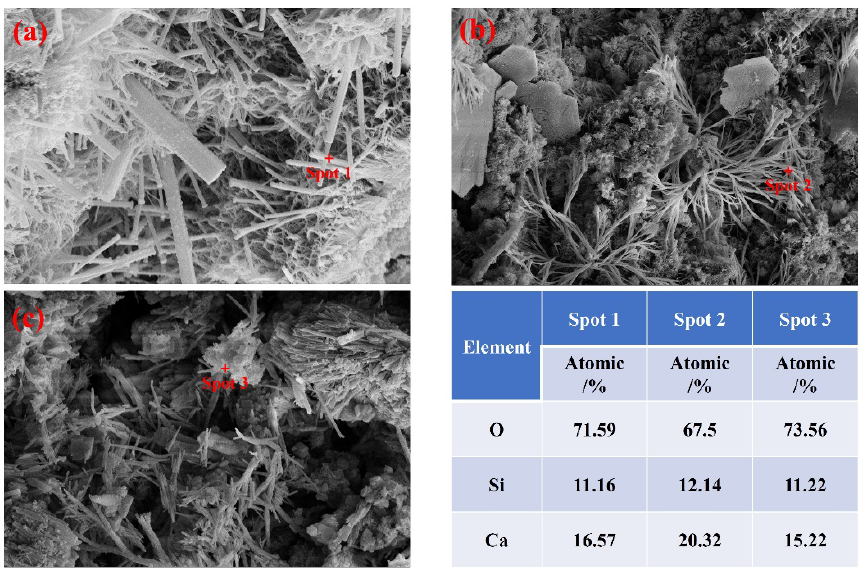
Figure 9. EDS of the specimens cured for 3 d: ( a ) PLH42.5, ( b ) PLH42.5-LP, and ( c ) PLH42.5-LPT.